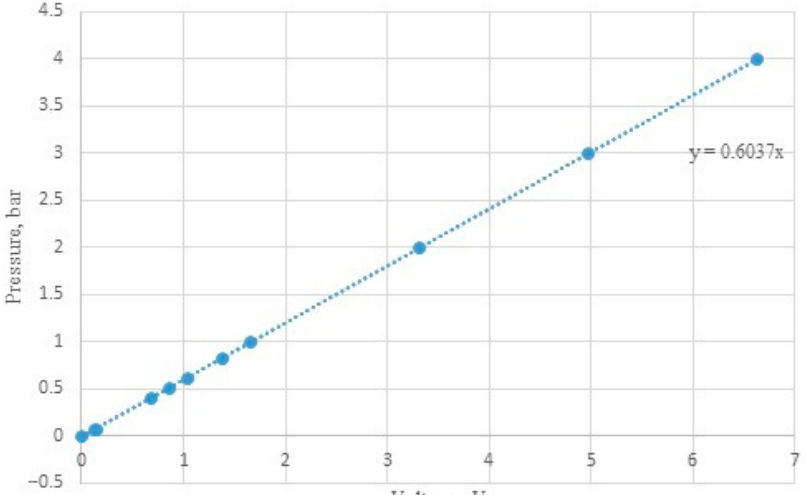
Figure 3. Calibration curve of the pressure sensor.